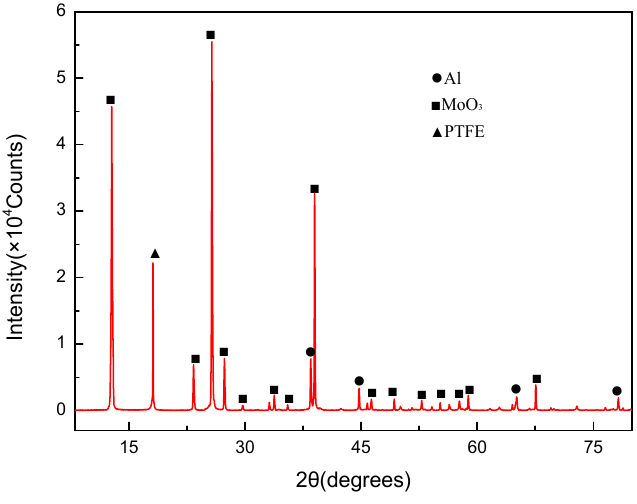
Figure 6. XRD pattern of PTFE/Al /MoO 3 composite.